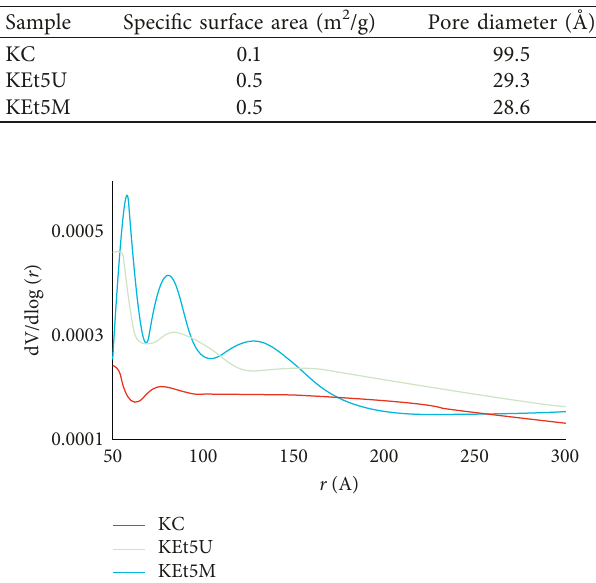
Table 2: Specific surface area and pore diameter of KC, KEt5U, and KEt5M samples.